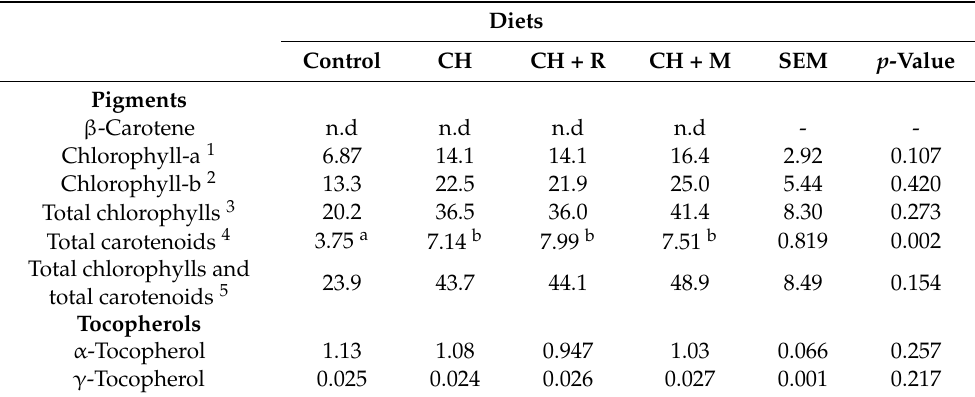
total carotenoids